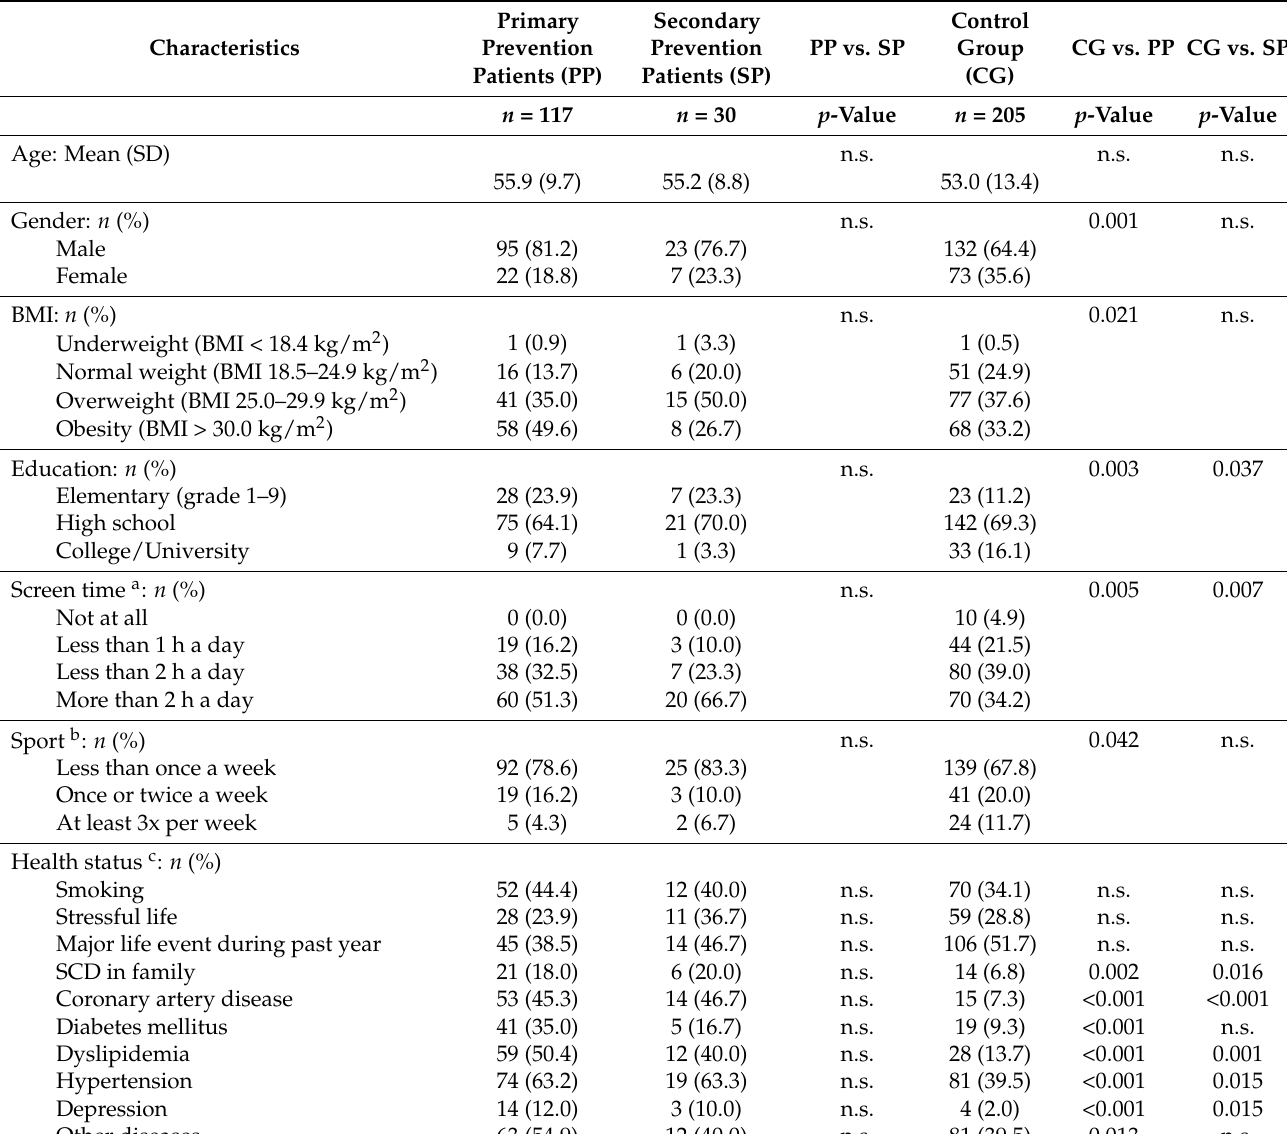
Table 1. Descriptive characteristics of the sample.